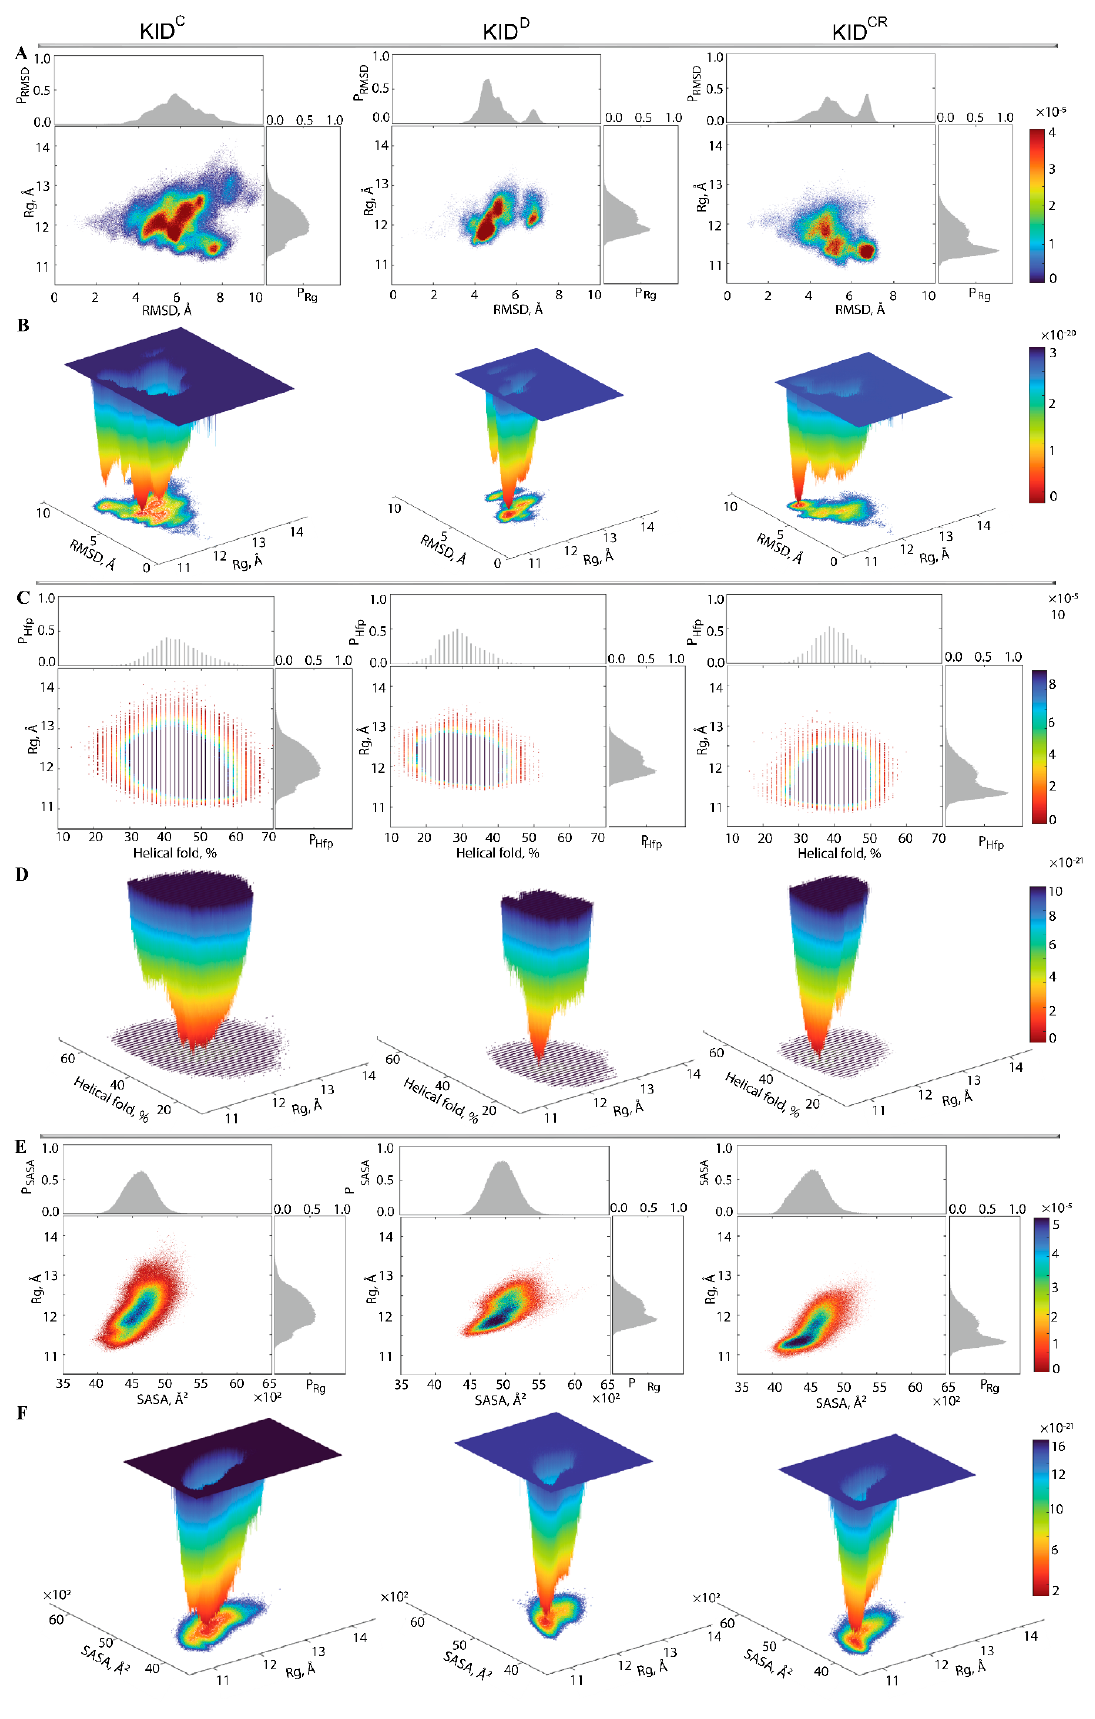
Figure 6. Free energy landscape (FEL) of KID as a function of the reaction coordinates. Each FEL generated on the